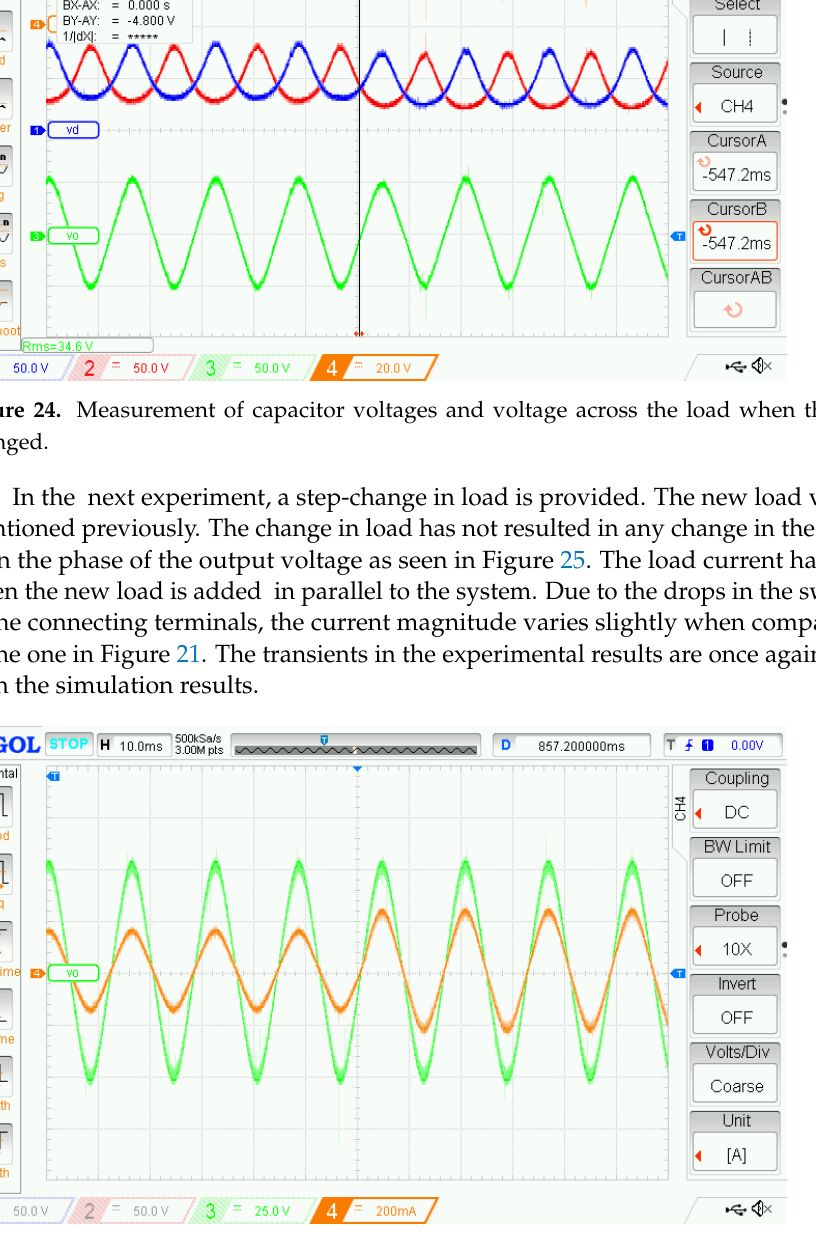
Figure 25. Measurement of load voltage and load current due to a step change in resistive